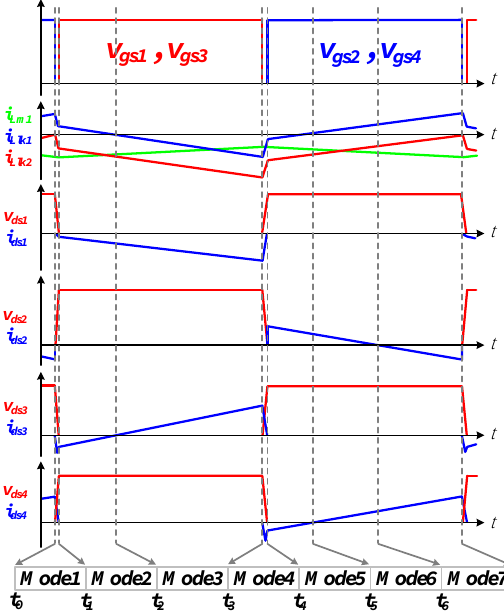
Figure 6. Key waveforms of the proposed topology in the step-down